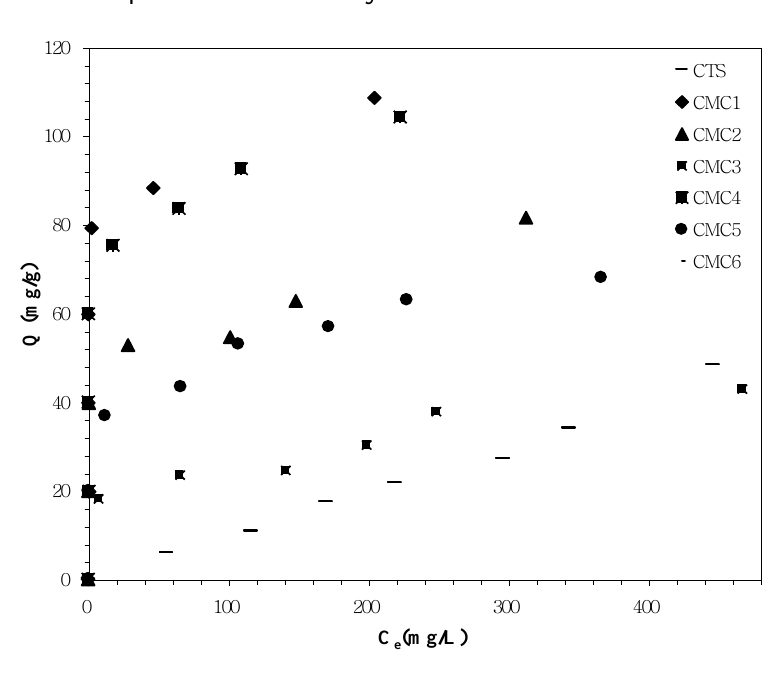
Figure 3. Adsorption of Zn 2+ ions by native and surface modified